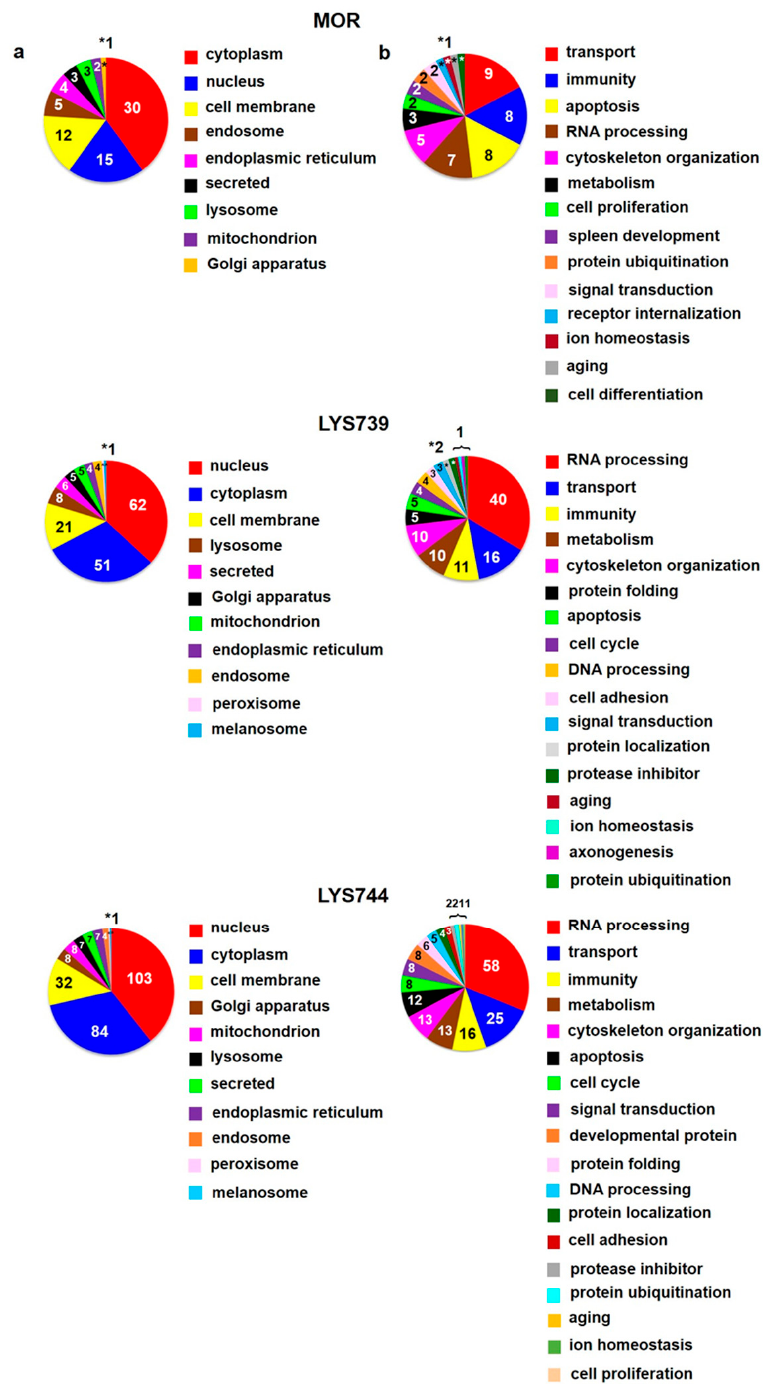
Figure 6. Subcellular localization ( a ) and function ( b ) of significantly altered proteins (at least 2-fold) identified in rat spleen lymphocytes after 7-day treatment with 10 mg/kg of morphine ( MOR , upper panels), LYS739 ( middle panels), and LYS744 ( lower panels); according to the current annotations in the Uniprot database (https://www.uniprot.org, accessed on 22 April 2022). The numbers represent proteins found within each subcellular localization and functional category, *1 or